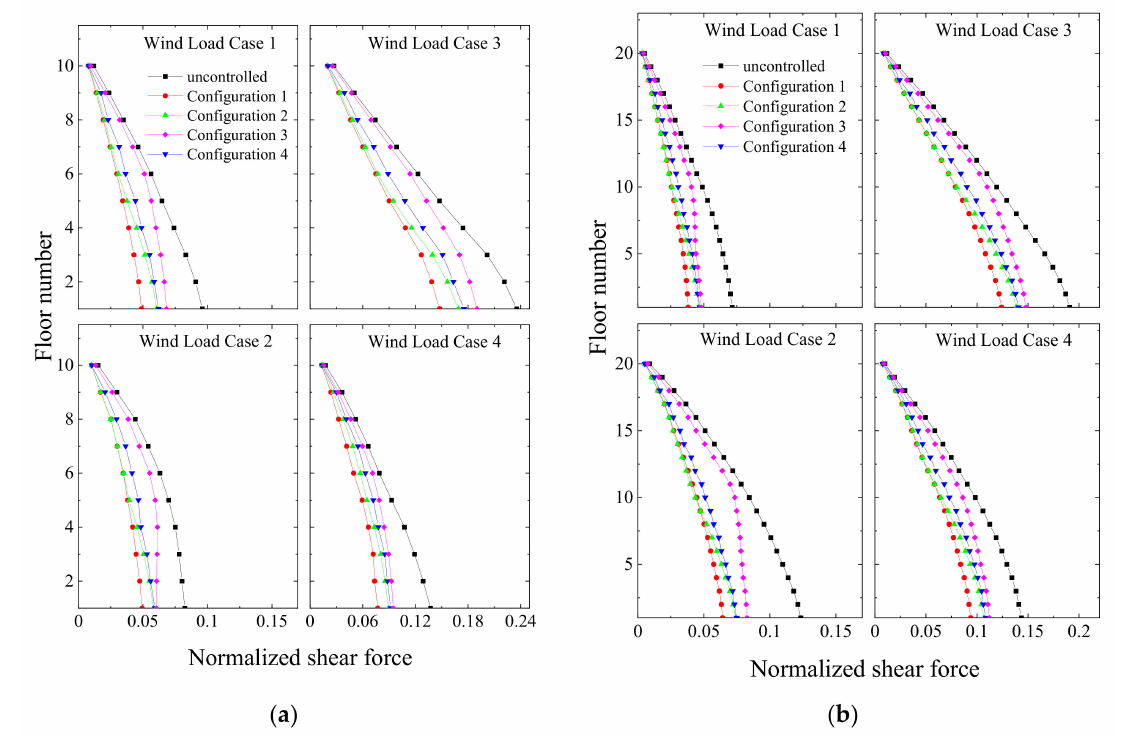
Figure 31. Peak floor shear under wind excitation in different damper configurations in: ( a ) a coupled stiff building and ( b ) a coupled flexible building under semi-active control of MR damper.